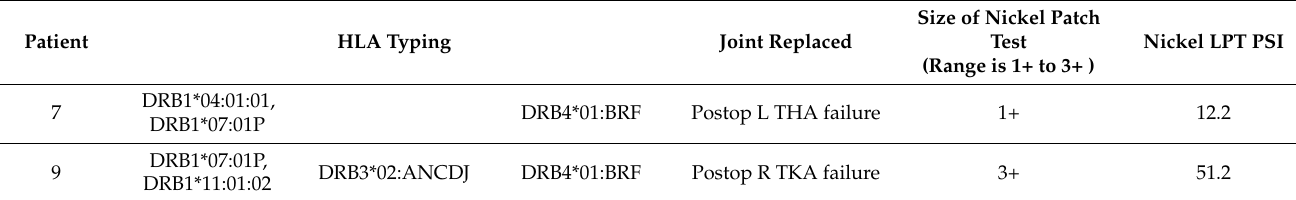
Table 1. Summary of clinical data from the two